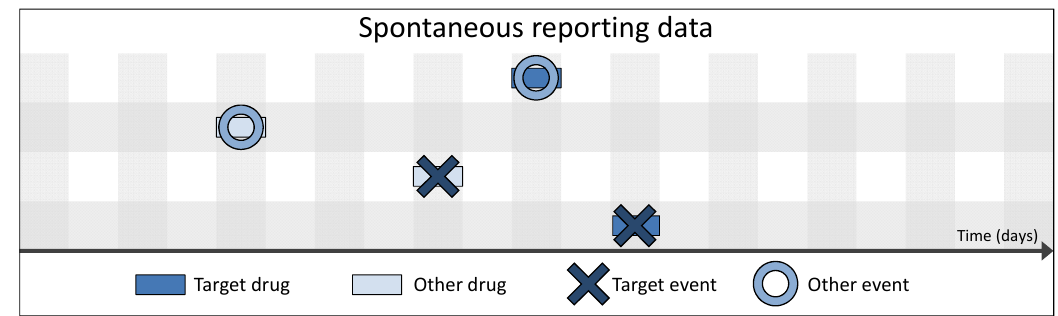
Figure 2. Schematic overview of the amount of information per patient contained in spontaneous reporting